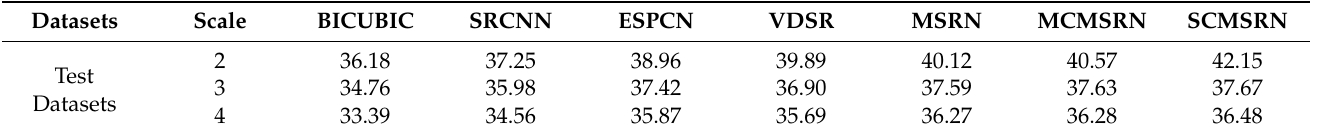
Table 1. The average PSNR of each algorithm on the melt image of the liquid metal sample (dB).